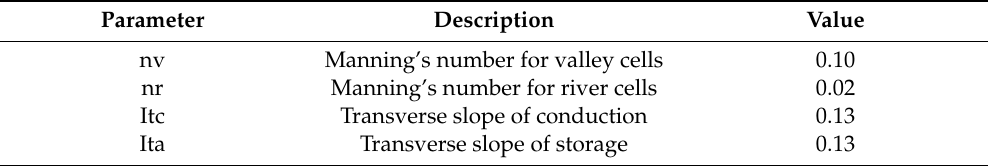
Table 5. The calibrated parameters in the CTSS8 model for the Santa Catalina stream